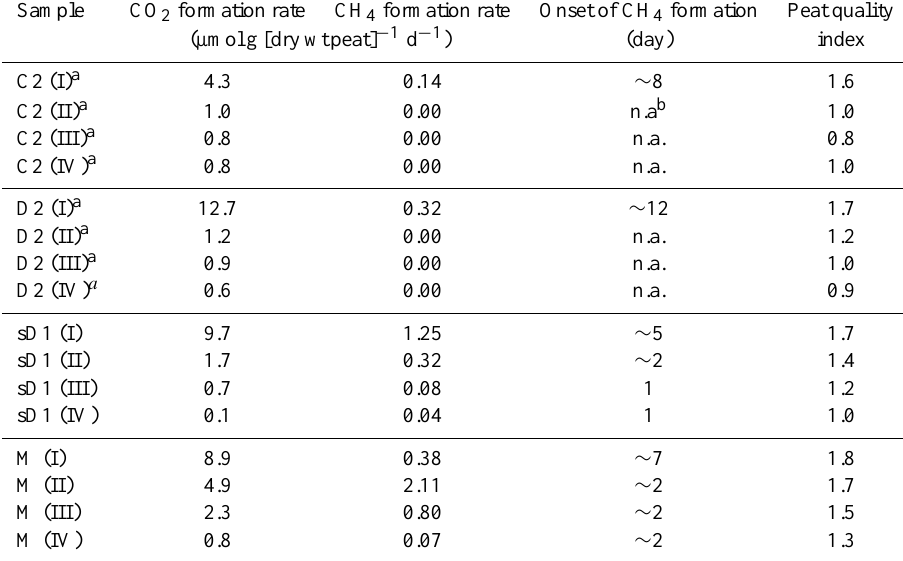
Table 3. Anaerobic formation rates of CO 2 and CH 4 , the onset of methanogenesis, and the peat quality index as ratio between the sum of thermal labile and recalcitrant C-based compounds and inert carbon compounds, (pyOM labile +pyOM recalcitrant ) /pyOM inert in peat obtained from an acidic fen (pH 4.7) along a hydrological gradient (from the middle to the south C2 → D2 → sD1 → M) over 4 depths (I: